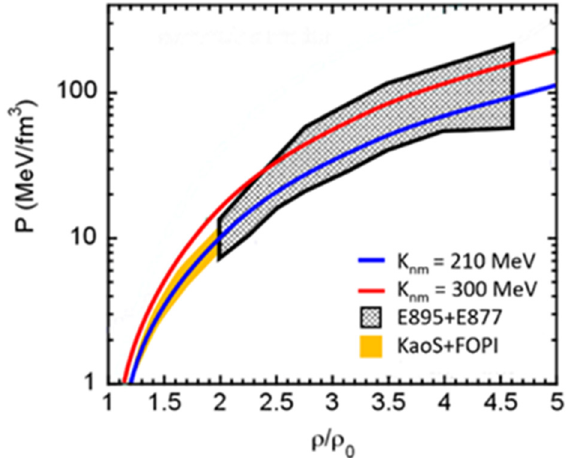
Figure 4. Pressure versus baryon density for symmetric nuclear matter. Grey hatched area: constraint provided by proton flow data taken at the AGS [11,12]. Yellow area: constraint from kaon data and fragment flow measured at GSI [7,8]. Red line: hard EOS, blue line: soft EOS [12].